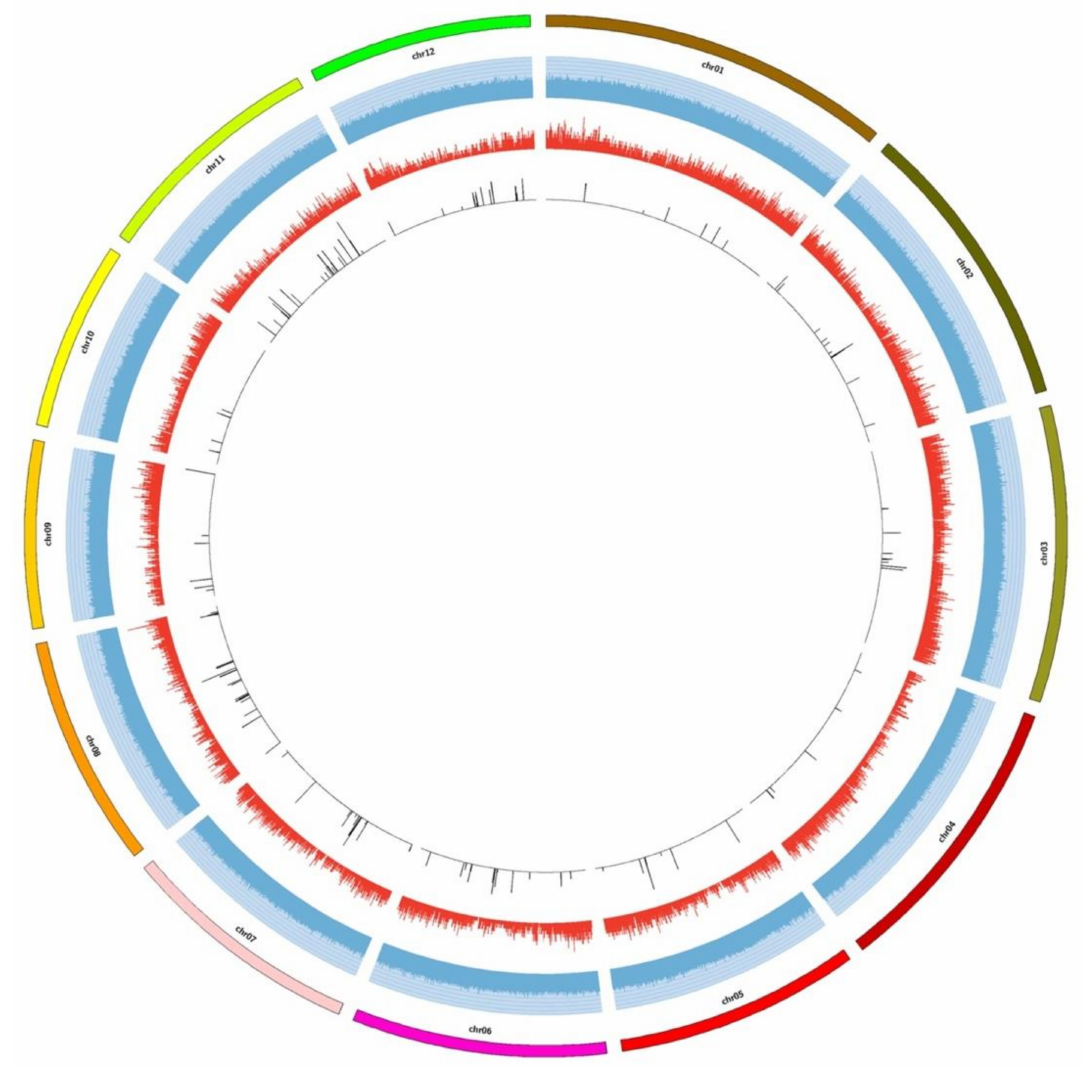
Figure 1. An annotated Circos plot depicts the distribution pattern of the selected SNP and InDel markers. The outermost circle represents 12 chromosomes of the rice genome. Blue bars represent the GC content of the rice genome, whereas red bars represent the gene frequency. In addition, the innermost black boxes represent the SNP and InDel markers identified in the Chinese rice